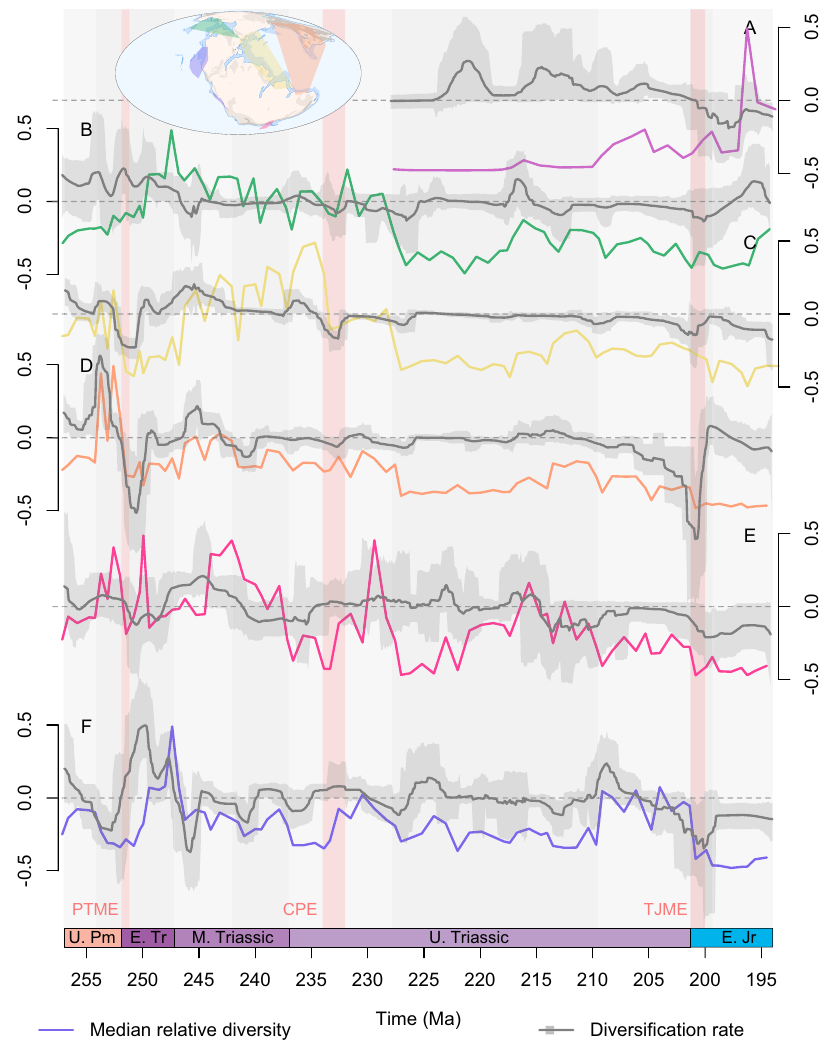
Fig. 3 Regional probabilistic median diversi fi cation rates, their 95% highest posterior densities, and median probabilistic diversity curves through the Late Permian to Early Jurassic (259.5 – 192.9 Ma). Diversi fi cation rates and the diversity curves resulting from these rates differ markedly between sampling regions, demonstrating that the accumulation of biodiversity is heterogenous around the globe through our study interval, even during globally pervasive biological upheavals like the end-Permian mass extinction (PTME), Carnian Pluvial Episode (CPE), or end-Triassic mass extinction (TJME). Displayed results are derived from PyRate and mcmcDivE analyses applied to datasets standardised by minimum spanning tree length, meaning that the results are unbiased by heterogenous sampling through time and across space. Y-axes are not provided for diversity as these values are rescaled so that the highest point in each time series is equal to 1 (see Fig. 2 for axes and con fi dence intervals). A South Panthalassic. B Boreal. C West Circumtethys. D East Circumtethys. E Tangaroan. F North Panthalassic. Source data are provided as a Source Data fi